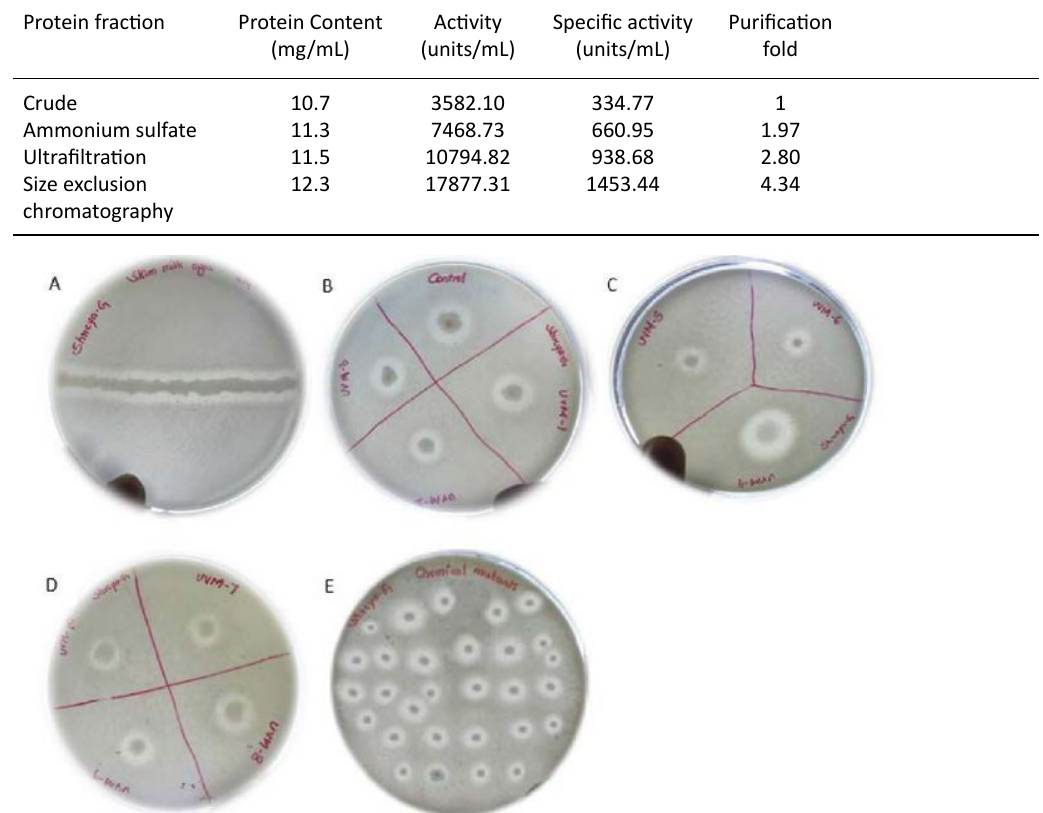
Fig. 3. Screening for proteolytic activity. (A) wild-type B) control (wild type) and S. marcescens UV mutants-1 (10s), UVM-2 (20s), UVM-3 (30s). ( C) UVM-4 (40s), UVM-5 (50s), UVM-6 (60-s), (D) UVM-7 (5min), UVM-8 (10min), UVM-9 (20min), UVM-10 (30min) and (E) EMS treated mutants, and UV+EMS treated mutants.